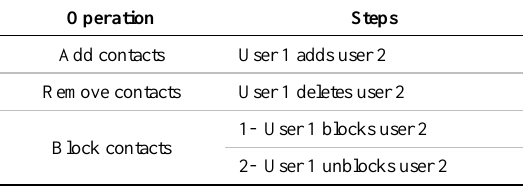
Table 1. User contacts experiments. User1 and User2 are the WhatsApp users involved in the experiments